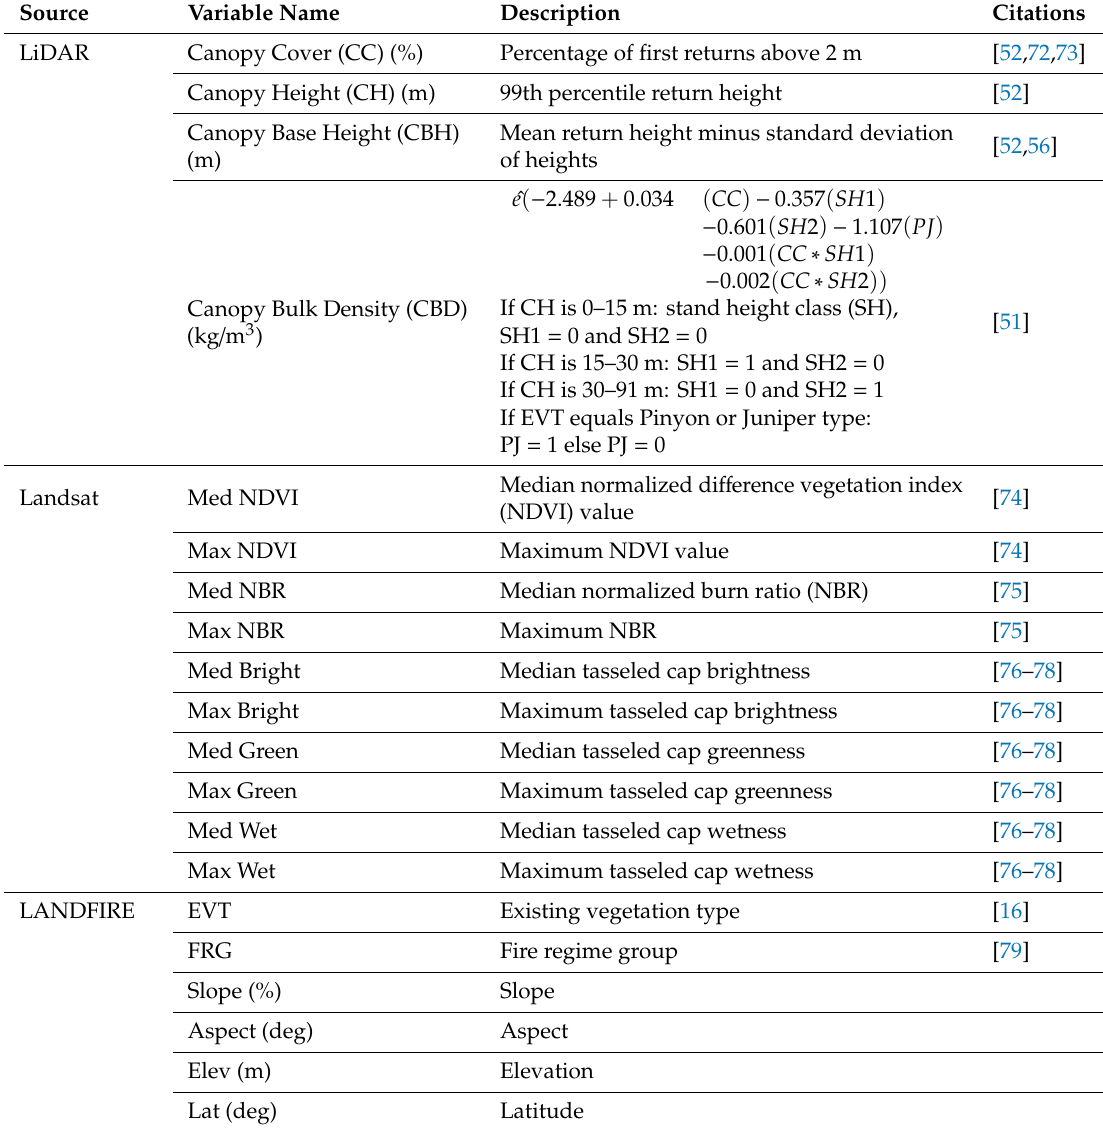
Table 1. Summary of canopy fuel response variables (LiDAR-sourced) and predictor variables used in the study. Existing vegetation type (EVT) and fire regime group (FRG) LANDFIRE variables filtered data instead of being used as predictor variables for model development. Median and maximum Landsat indices derived from May to Oct